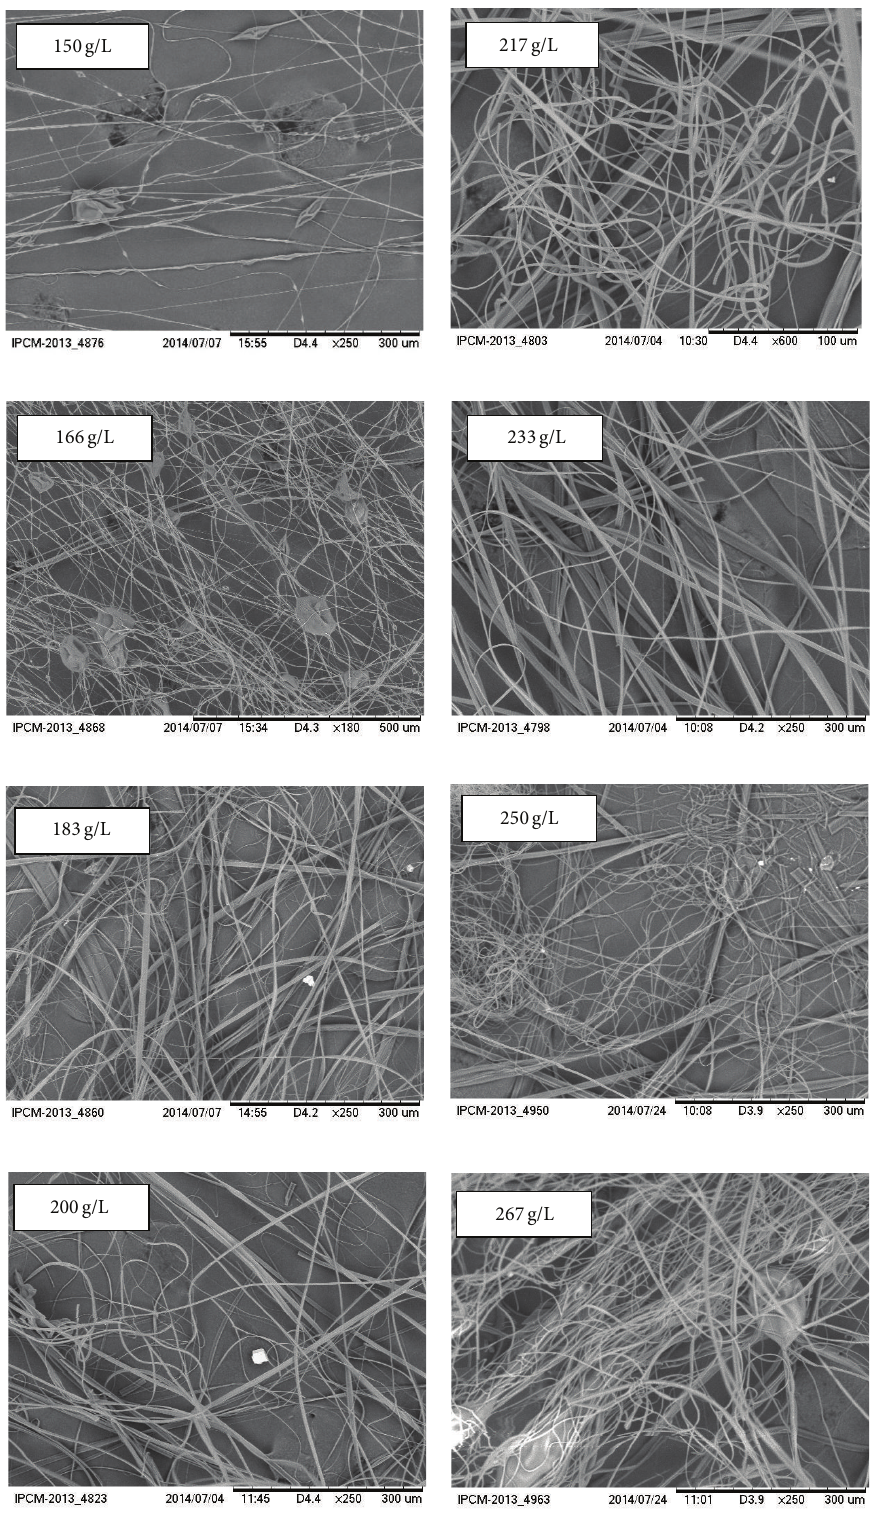
Figure 2: Comparison of electrospun fibers of Eudragit L-100 as a function of concentration of polymer (range of 150g/L to 267